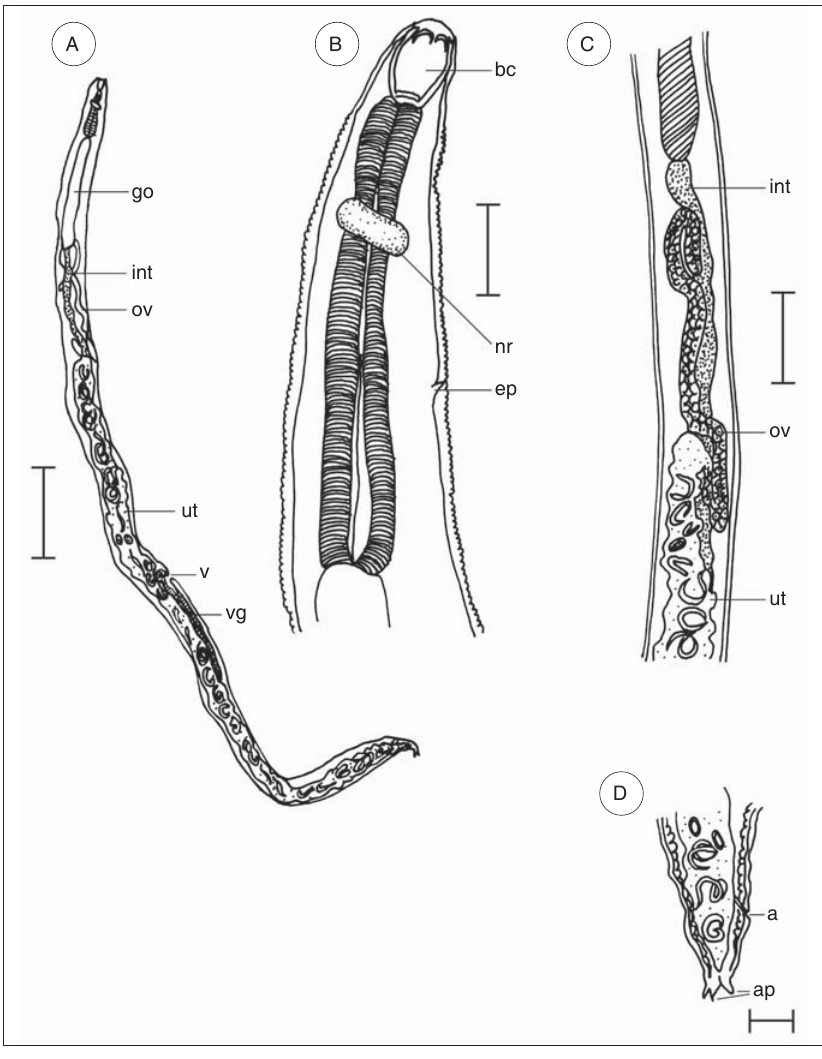
FIG. 2 Procamallanus laevionchus female drawings. (A) whole worm. Scale bar = 400 μ m; (B) anterior end. Scale bar = 100 μ m; (C) mid-body. Scale bar = 200 μ m; (D) posteri- or end. Scale bar = 20 μ m. a = anus, ap = anal (tail) processes, bc = buccal capsule, ep = excretory pore, go = glandular oesophagus, int = intestine, nr = nerve ring, ov = ovary, ut = uterus, v = vulva, vg